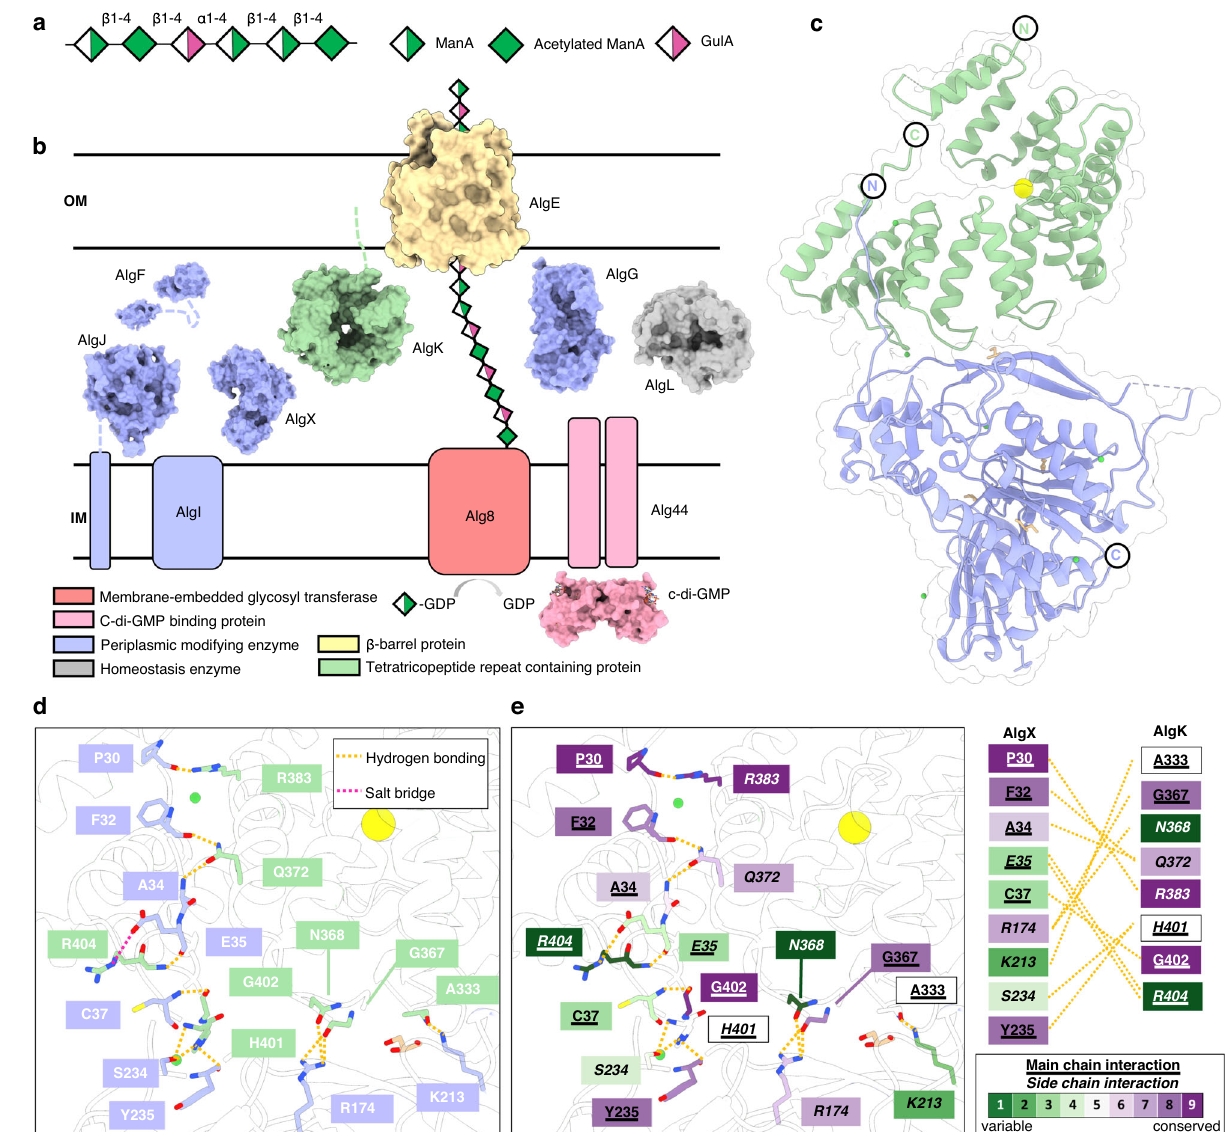
Fig. 1 | Structure of the AlgKX complex. a Schematic of the alginate exopoly- saccharide. Alginate is a random polymer composed of 1 – 4 linked α - L -guluronate (GulA) residues and ß- D -mannuronate (ManA) residues. ManA residues can be O- acetylated (Acetylated ManA). b Depiction of proteins involved in the alginate biosynthesissynthase-dependentsecretionsystemorganizedbyfunction.ThePilZ domain of Alg44 (PDB: 4RT0) 16 binds to c-di-GMP in the cytoplasm, triggering ManA polymerization by Alg8 from GDP-ManA and its translocation across the inner membrane (IM).Once in the periplasmicspace, AlgI, AlgJ(PDB:4O8V) 19 , AlgF (PDB:6CZT),andAlgX(PDB:4KNC) 18 modifyManAresiduesby O -acetylation.AlgG (PDB: 4OZZ) 20 epimerizes unacetylatedManA residues toGulA 13 . AlgL (PDB: 4OZV) degrades alginate that accumulates in the periplasmic space 25 . AlgK (PDB: 3E4B) 23